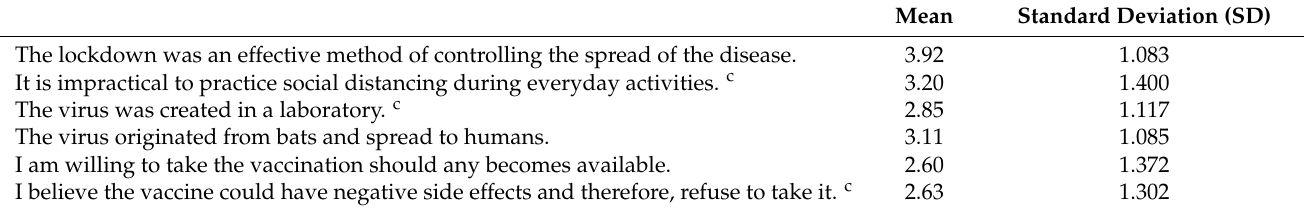
Table 5. Students’ perceptions about